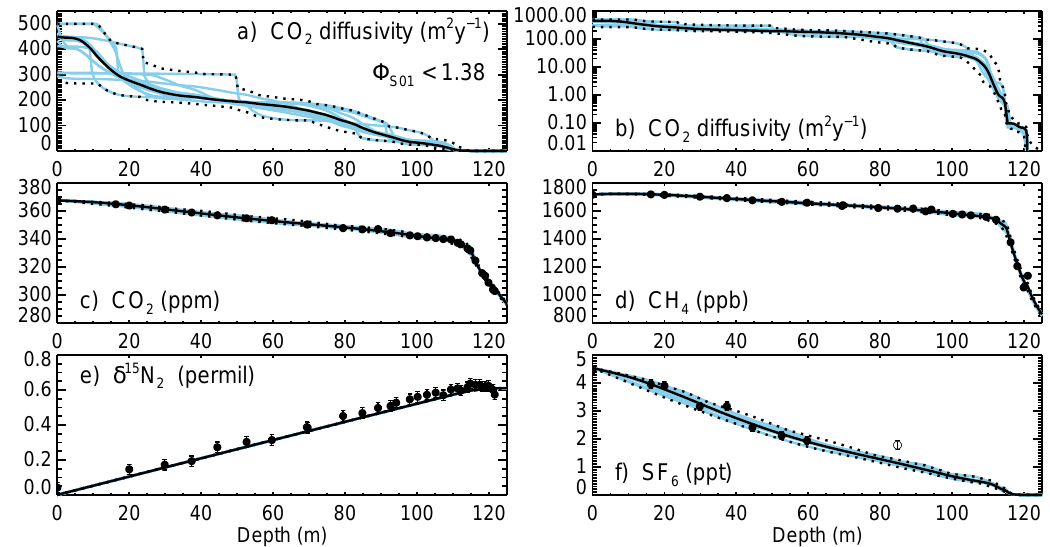
Fig. 12. Diffusivity and tracers at South Pole 2001 for 8 S01 < 1 . 38. Solid circles show observations used for calibration, open circles show additional measurements that were not used for